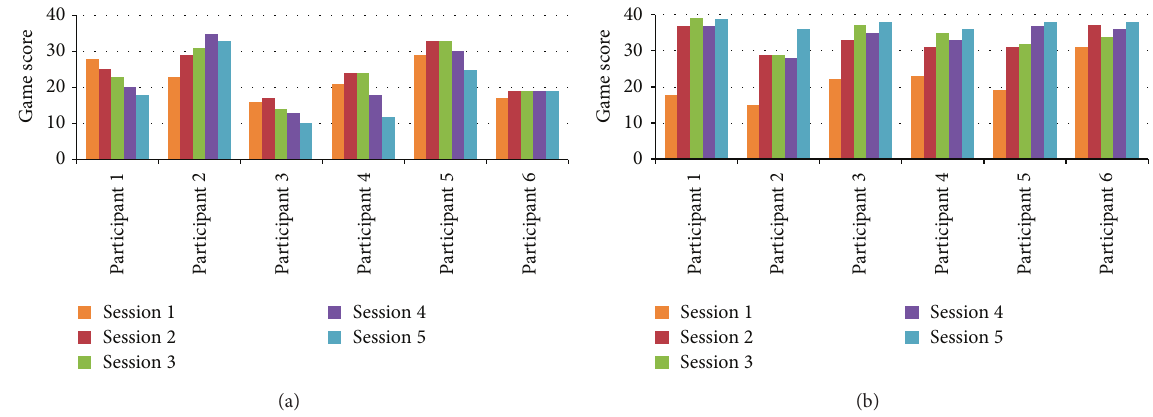
Figure 4: Participant’s performance on the penguin game over the 5 training bouts (3 󸀠 each): MS participants (a) and healthy participants